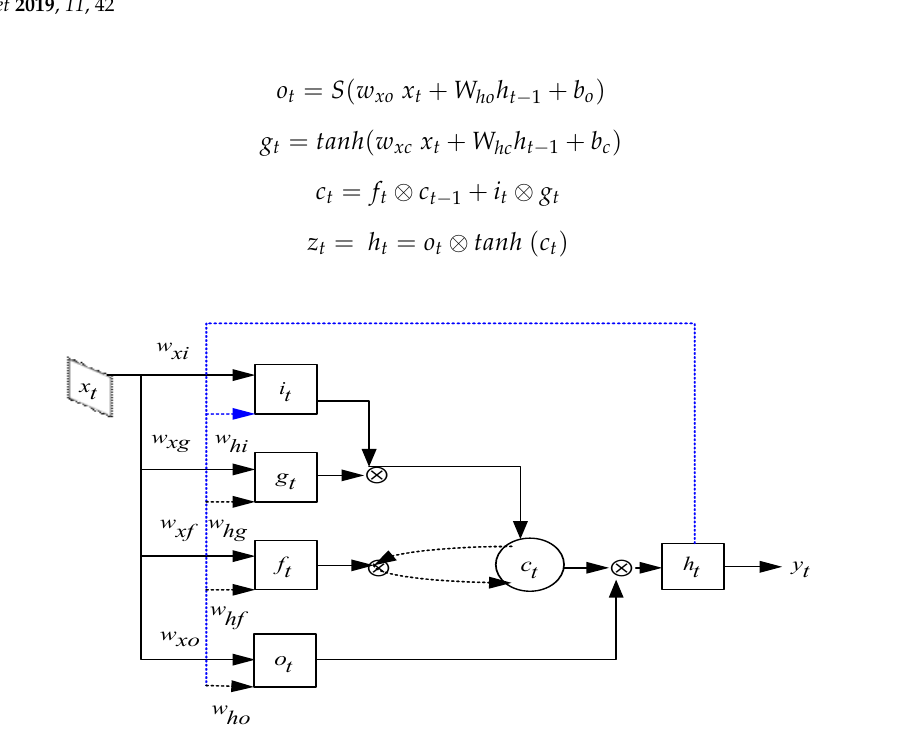
Figure 5. The architecture of LSTM Unit.